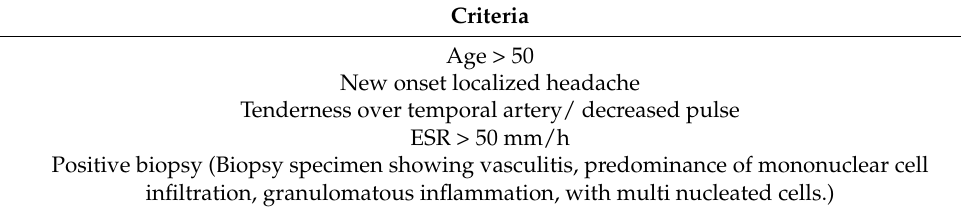
Table 2. rACR criteria a